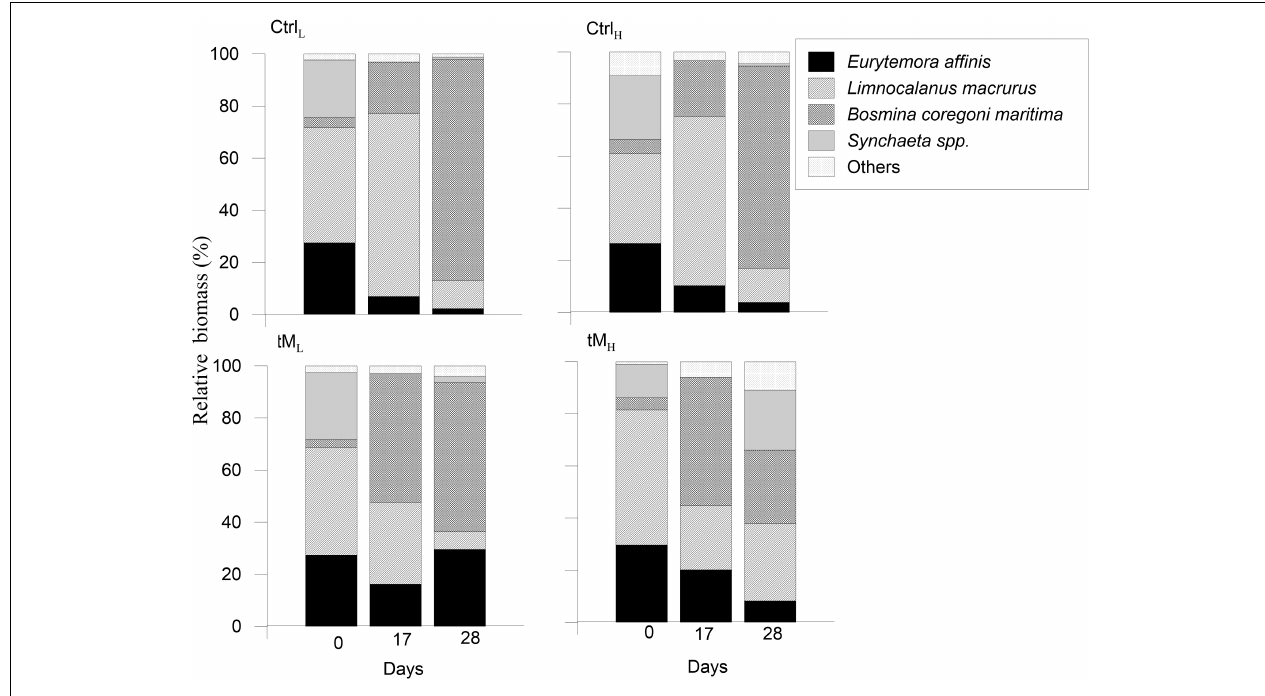
FIGURE 10 | Mesozooplankton taxonomic composition at the start, middle and end of the experiment (Day 0, Day 17, and Day 28) in all treatments.